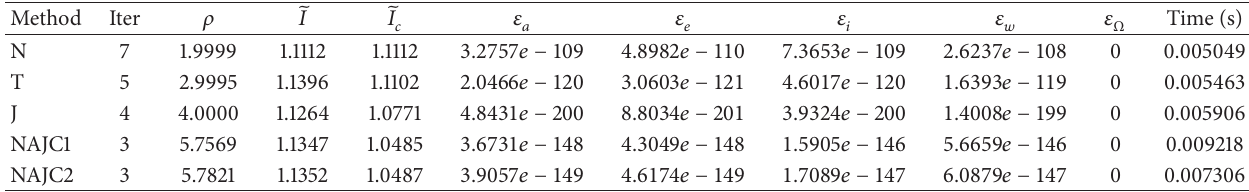
Table 3: Results of reference Orbit I.